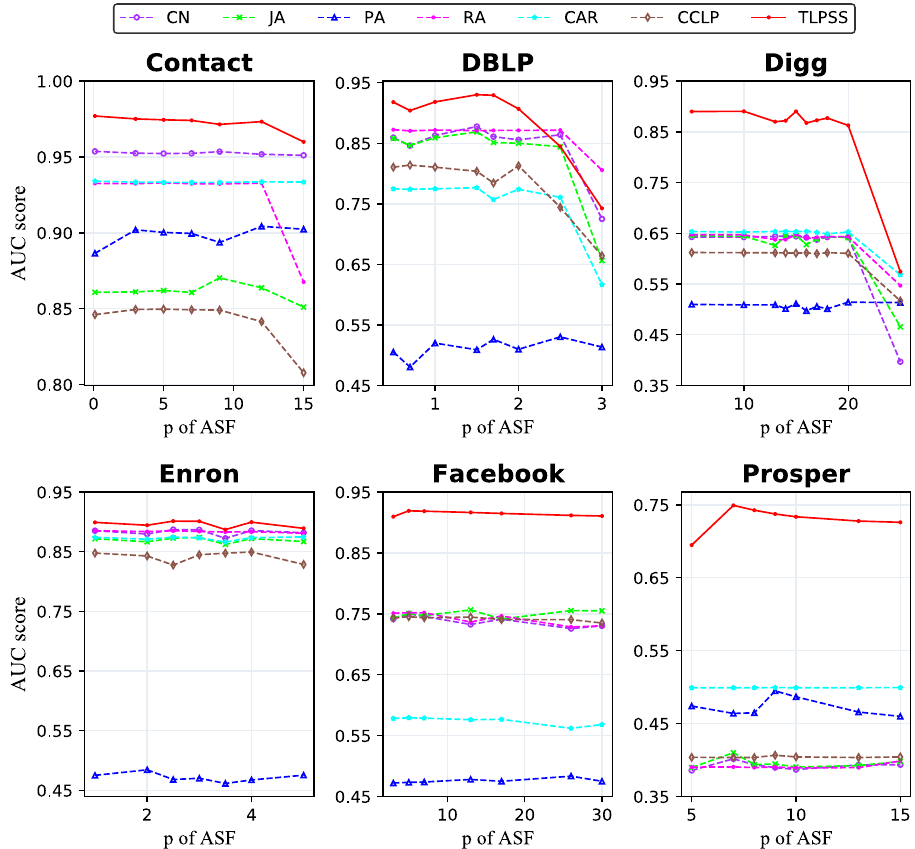
Figure 6. Performance comparison of varying parameter p in different dynamic networks. All methods are based on the same temporal information decayed by ASF . The performance of TLPSS is superior to other baseline